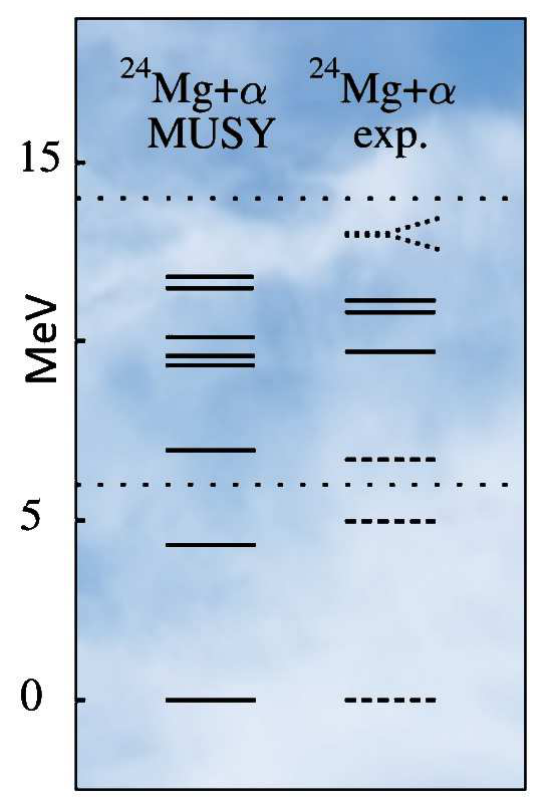
Figure 4. (Color online) Left-hand side: the 0 + spectrum of the 24 Mg + 4 He configuration, predicted by the MUSY from the quar- tet model description of the low-energy spectrum of 28 Si. Right- hand side: the experimental states. The energy window between the dotted lines shows the range of the inelastic alpha-scattering experiment, resulting in the states of solid lines. The states of dashed lines are from other